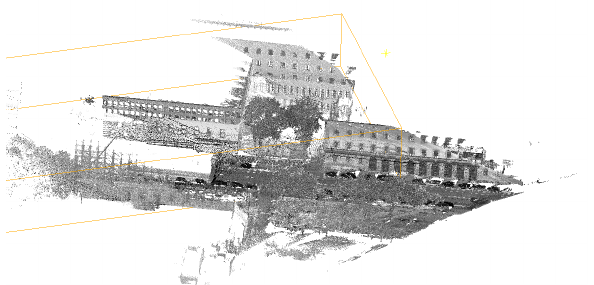
Figure 4. Original Point